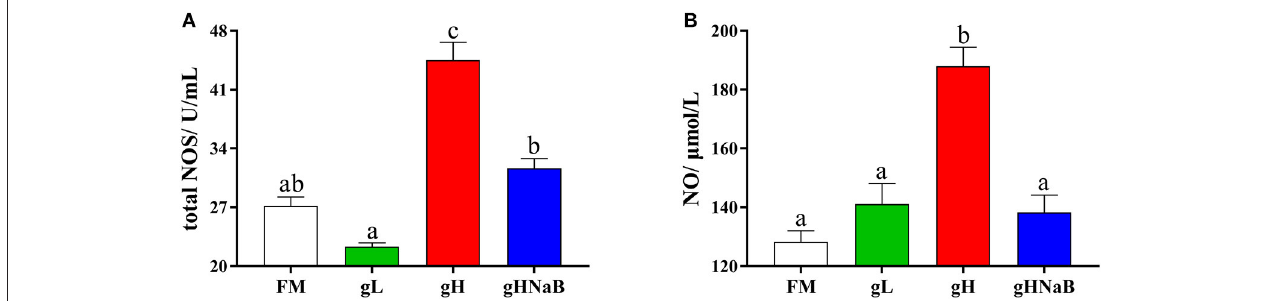
FIGURE 2 | Effects of different treatments on the mRNA levels of immune-related genes (A) , including tnf α , il1 β , tgf β 1 , hepcidin , il6 , il8 and ifn γ , and tight junction-related genes (B) , including jam , occludin , claudin3 , claudin12 , claudin15 and zo1 in the distal intestine of hybrid grouper. Values were means of eight replicates ( n = 8), and were represented as mean ± standard error. a,b,c,d Mean values with unlike letters were significantly different ( P < 0.05).